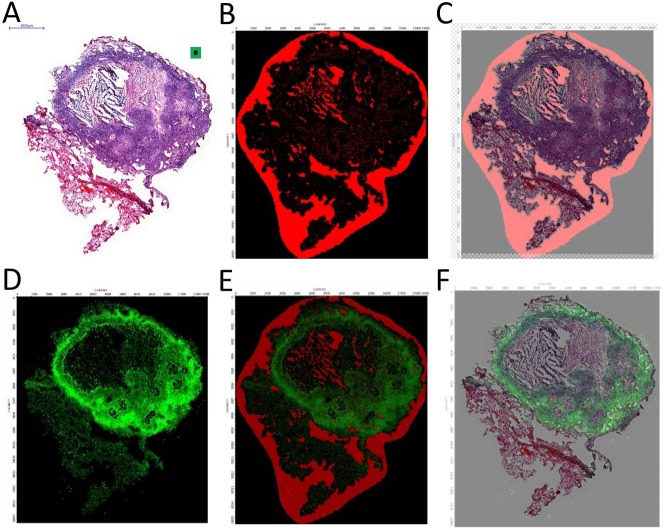
Workflow for overlaying MALDI-MSI and histology images.(A) H and E stained tissue, obtained from the same section used for MALDI MS imaging, after washing of the DHB matrix; (B) Map of matrix ion m/z 362,217, a matrix-related peak highly abundant outside of the tissue and used to revealed contours of the tissue border and hollow bronchioles within; (C) Alignment of the matrix ion and H and E images; (D) Moxifloxacin [M + K]+ion image (m/z 440,138 normalized to internal standard MXF-d4 m/z 444,1638); (E) Normalized MXF image aligned with the matrix marker image using the Thermo ImageQuest image ruler; (F) MXF intensity map aligned and overlaid with H and E image of the same section.